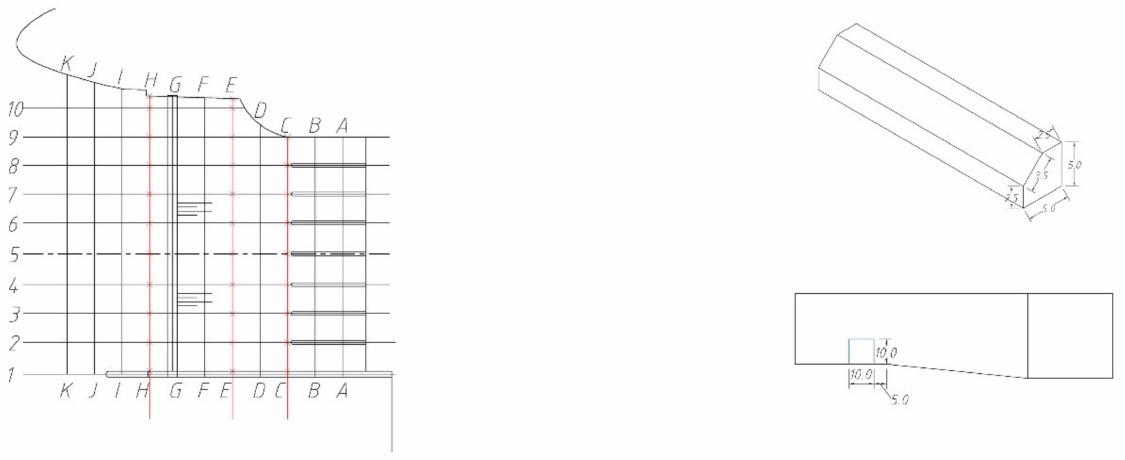
Figure 13. Plan 7 (unit: